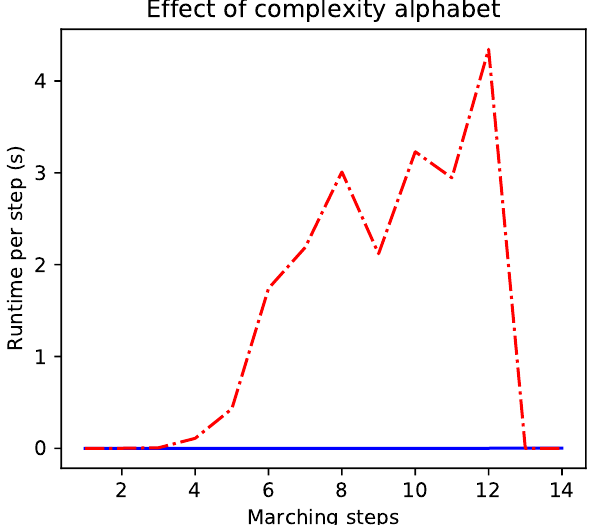
Figure 1. Time to discovery (s): Fast versus Slow brute force. The Slow search cuts off at 12 due to maximum complexity.